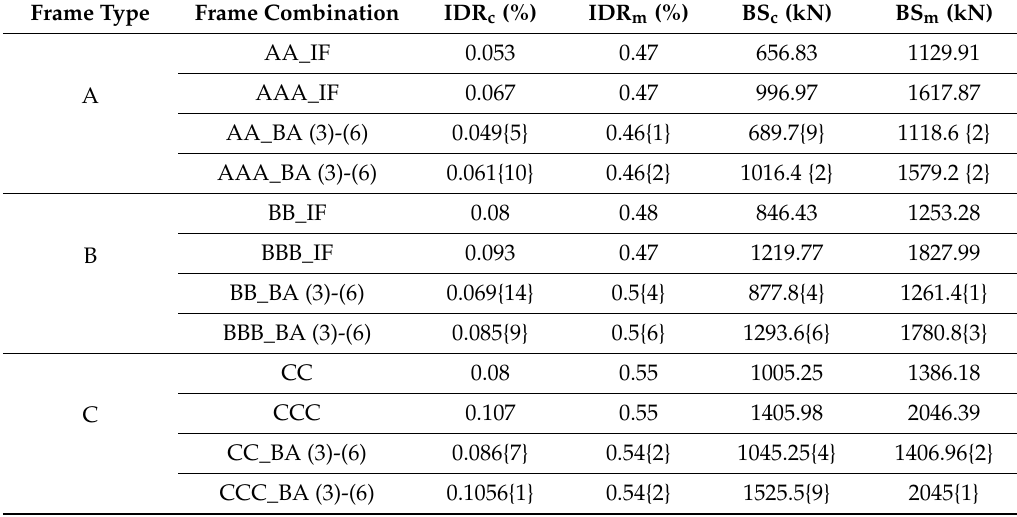
Figure 8. Capacity curves for multi-bay frames with same bay length. Table 9. Evaluation of accuracy of proposed bilinear approximation equations for equal bay length.